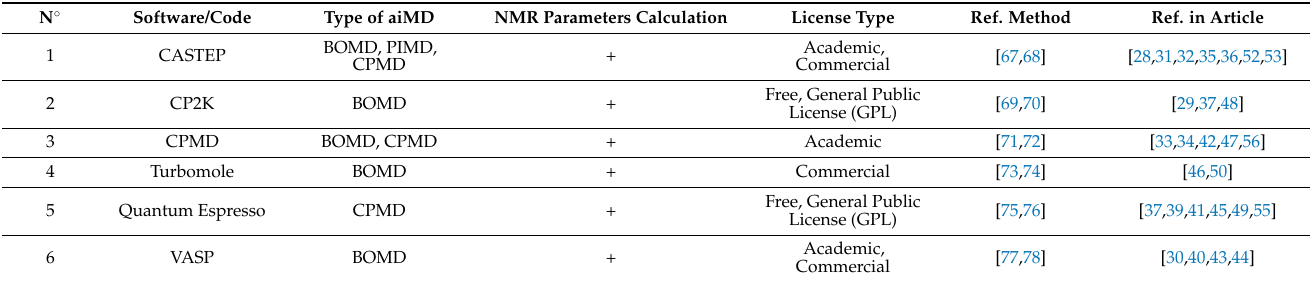
Table 3. Software applied in aiMD combined with the DFT-based NMR calculations. “+” indicates that this is possible to request the NMR parameters calculation in that software. N ◦ Software/Code NMR Parameters Calculation Ref.